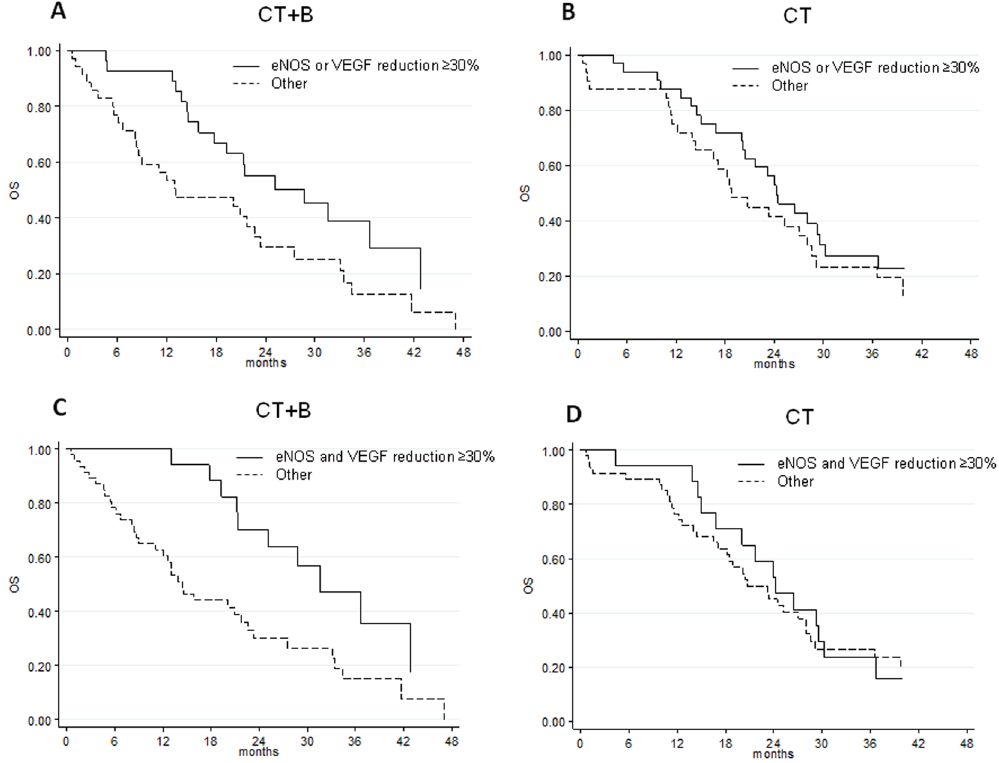
Figure 2. OS with respect to reduction in eNOS levels in CT + B ( A ) and CT ( B ) groups, and with respect to VEGF reduction in CT + B ( C ) and CT ( D )